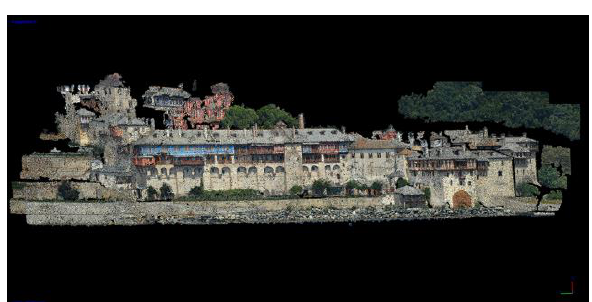
Figure 5 . The Monastery of Xenophontos. Cloud of points.